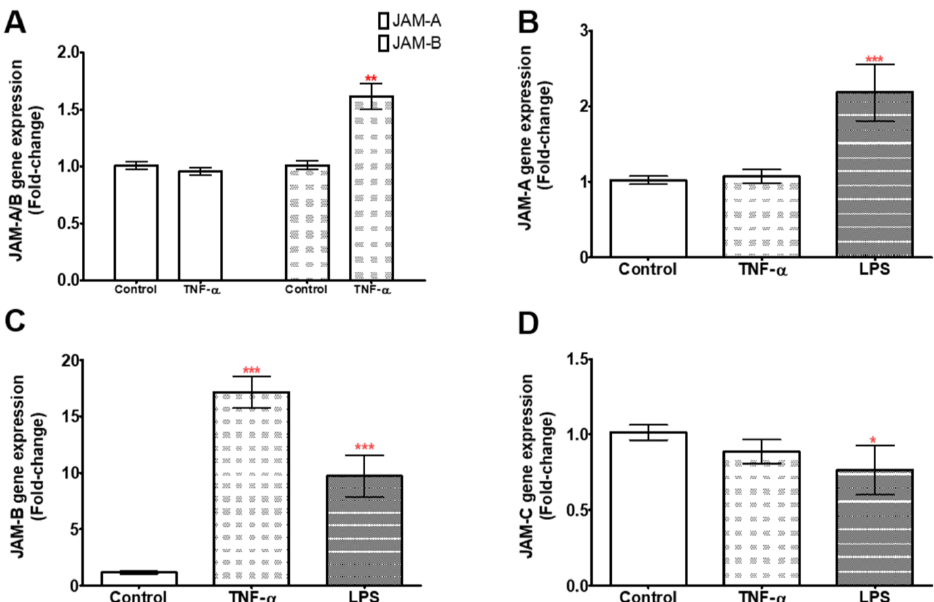
Figure 2. Fold-changes in JAM gene expression in response to TNF-α and LPS treatments for 24 h relative to the geometric mean of YWHAZ and ACT-β expression. All data are the relative expression of the JAMs treated with TNF-α or LPS compared to the respective non-treated control. ( A ) JAM-A and JAM-B expression in THP-1-differentiated macrophages. ( B – D ) Relative expression of JAM-A, JAM-B and JAM-C, respectively, in THP-1 monocytes. *** indicates p ≤ 0.0001, ** indicates p ≤ 0.01, * indicates p ≤ 0.05. n = 9 for TNF-α treatments and n = 6 for LPS treatments. Data are mean ± SEM.